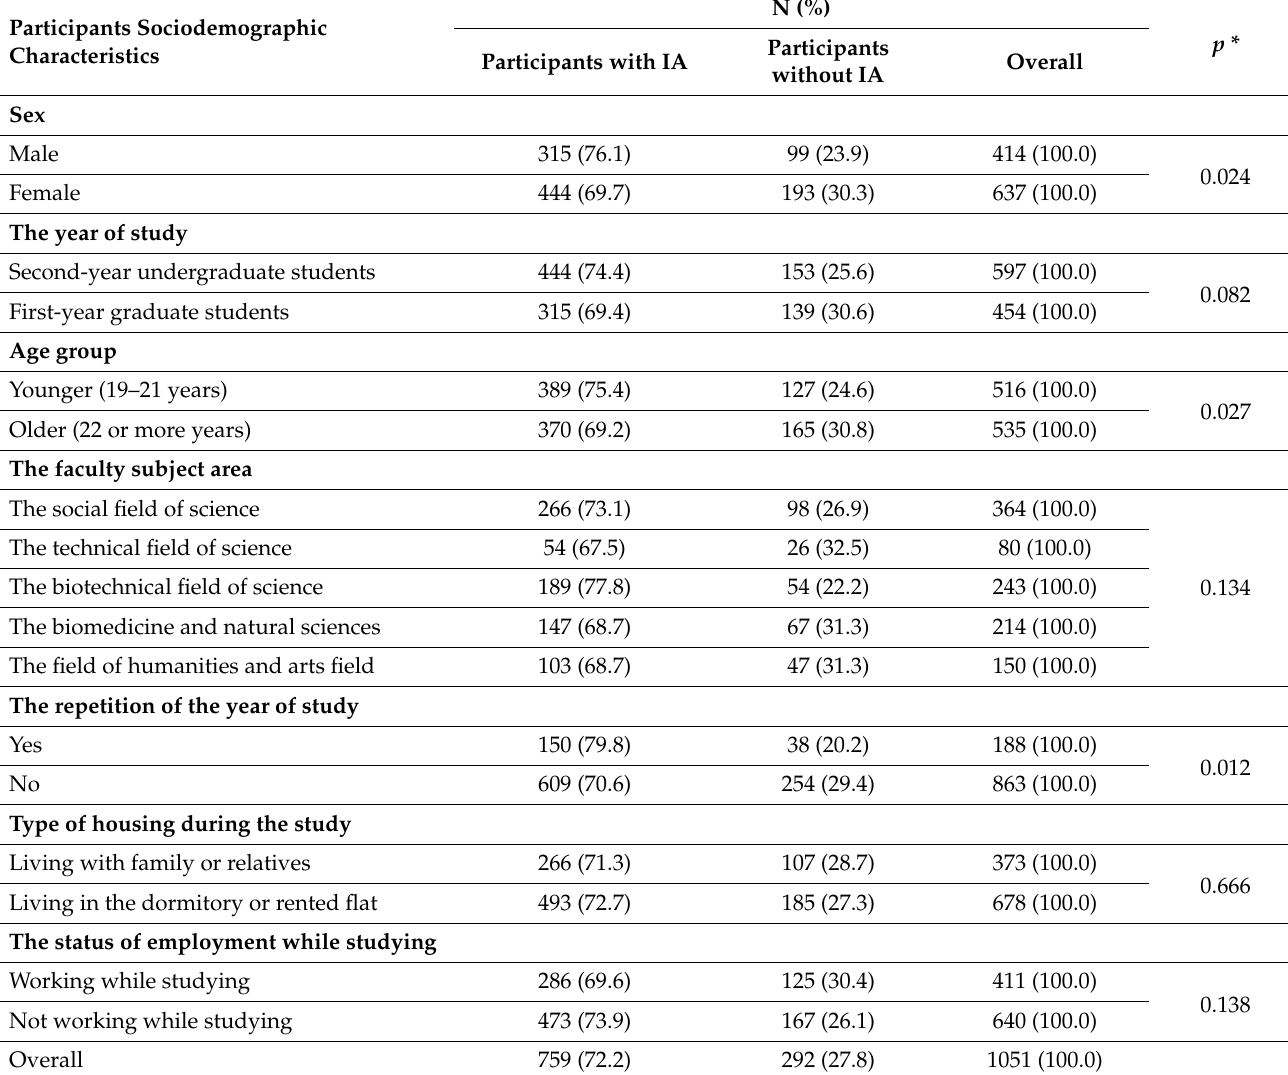
Table 2. Participants with or without IA according to their sociodemographic